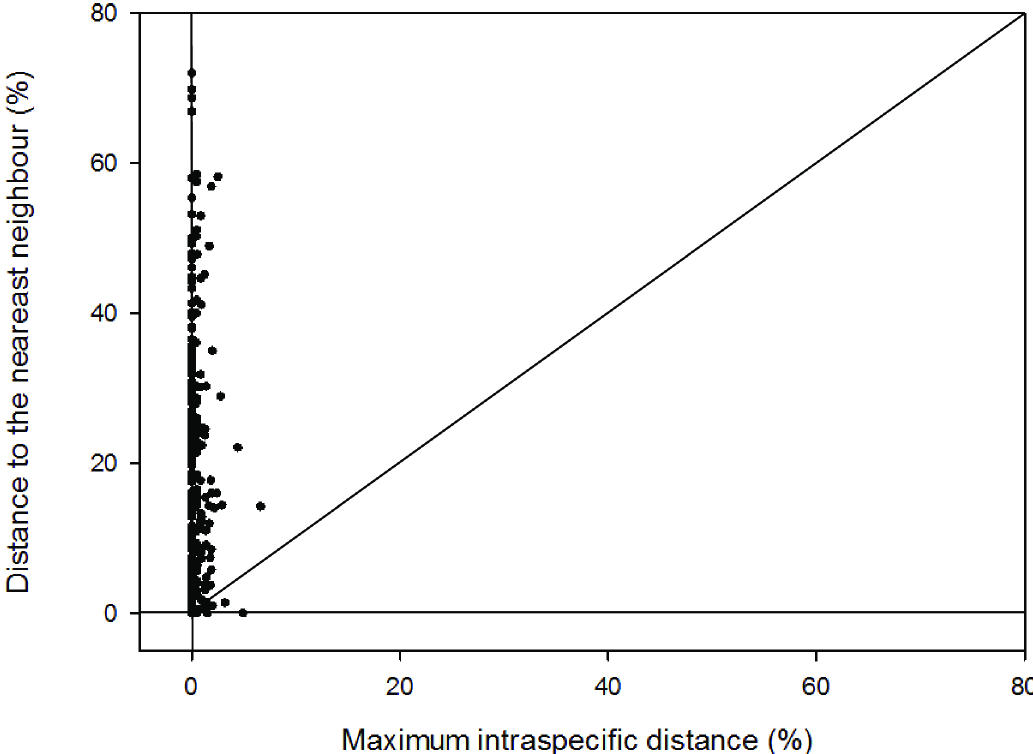
Fig 4. Scatter plots of maximum intraspecific K2P distance VS minimum distance to the nearest neighbor based on ITS2 barcodes.